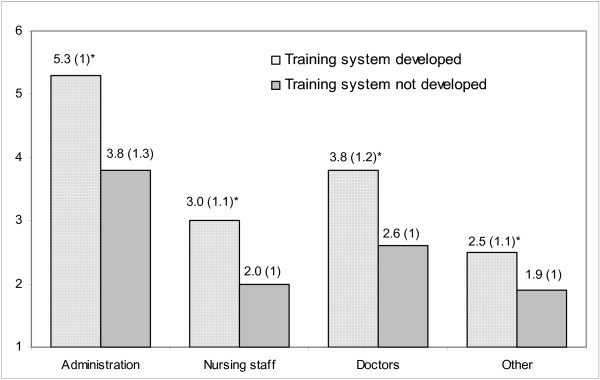
Mean score of perceived employee quality management competence in respect to the existence of respective training systems (standard deviation).